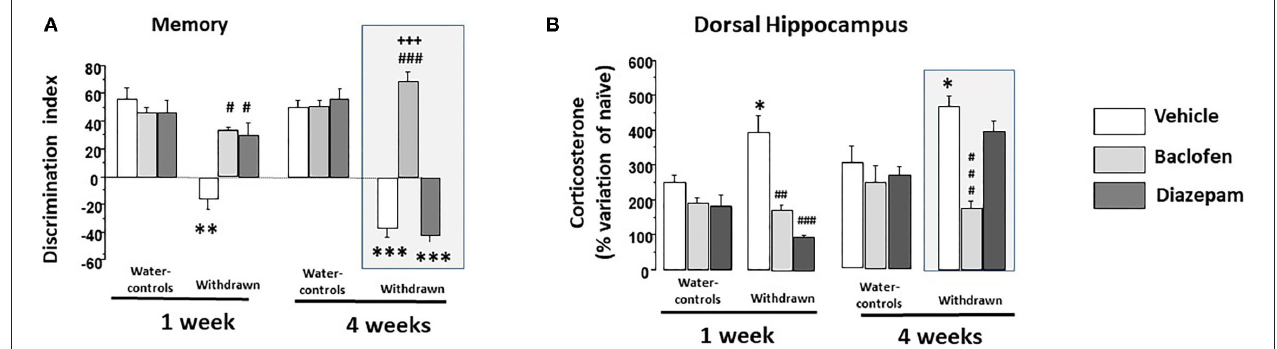
FIGURE 5 | (A) Memory: in 1-W groups (left part), water-controls being injected either with vehicle (white square), diazepam (light gray square) or baclofen (dark gray square) exhibited high and similar discrimination indexes; in contrast, 1-W vehicle-withdrawn mice exhibited a significant negative discrimination index as compared to the vehicle-water group (** p < 0.01). 1-W withdrawn groups treated with diazepam or baclofen did not significantly differed from vehicle-water controls ( p > 0.10 in each comparisons), which were significantly higher than that of the vehicle-withdrawn group (## p < 0.01 in both comparisons); in 4-W groups (right part), water-controls treated with vehicle or diazepam or baclofen exhibited high and similar discrimination indexes; in contrast, 4-W vehicle or diazepam-withdrawn mice exhibited significant negative discrimination indexes as compared to the vehicle-water group (*** p < 0.001 in both comparisons). In contrast, baclofen-withdrawn mice exhibited performance similar to those of vehicle-water controls which were significantly higher than that of the vehicle-withdrawn and diazepam-withdrawn groups (### p < 0.001 in both comparisons); (B) Test-induced increase of corticosterone concentration (TICC) in the dorsal hippocampus (dHPC) from naïve condition; as can be observed, 1- and 4-W vehicle-withdrawn mice exhibited a higher TICC score as compared to respective vehicle-Water-controls (* p < 0.05 in each comparison). Both diazepam and baclofen 1-W-withdrawn mice exhibited a significant attenuation of the TICC score as compared to vehicle -withdrawn 1-W mice (### and ##: p < 0.001 and p < 0.01, respectively); in contrast however, only baclofen-withdrawn mice still exhibited a significant attenuation of the TICC score in 4-W-withdrawn animals as compared to both vehicle-treated and diazepam-treated withdrawn groups (### p < 0.001 in both comparisons). # p <